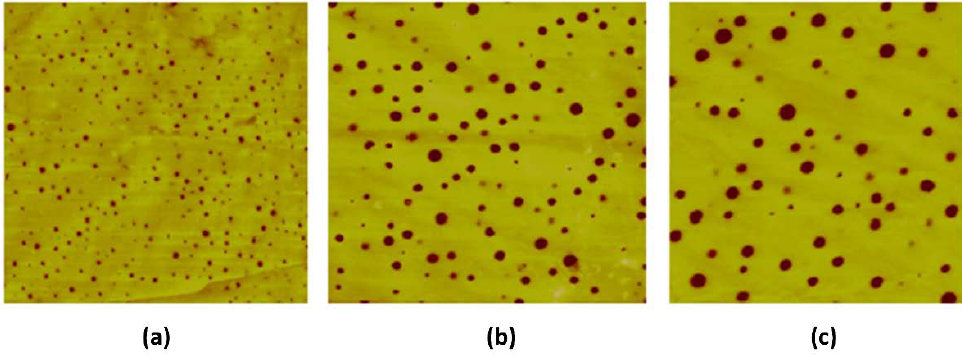
Figure 7. AFM images of Corning 7070 glass after heat treatment at 700 °C for ( a ) 1 h, ( b ) 8 h, and ( c ) 24 h. All scans are 2 × 2 µm [104]. Reprinted with permission from Elsevier; published by Wheaton et al . , 2007.